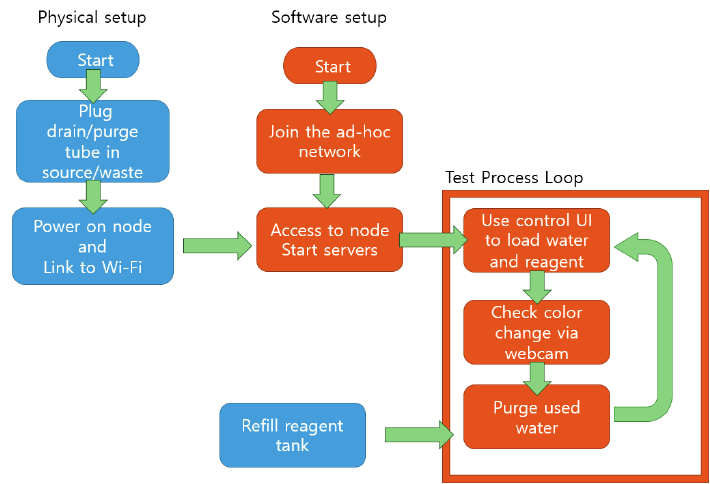
Figure 7. Operation scenario of the sensor node. Blue flowchart shows physical setup and processes while brown flowchart indicates software setup and